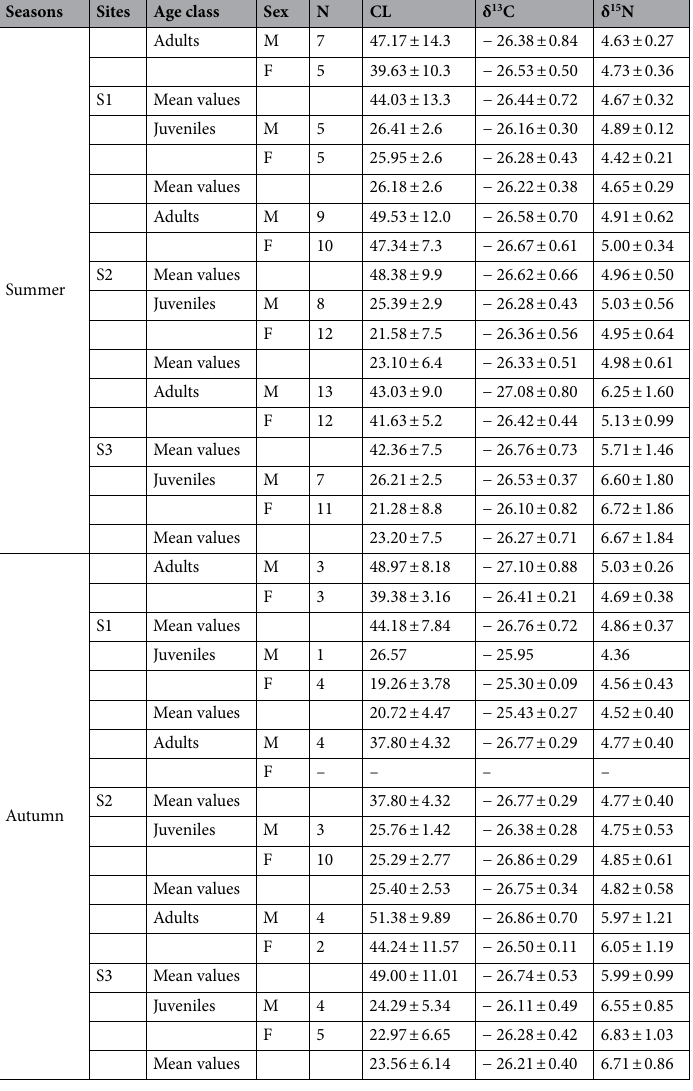
Table 1. Signal crayfish mean (± SD) stable isotope values of carbon and nitrogen, carapace length (CL), number of sampled individuals between sexes, age classes, and sites in Valla Stream in summer and